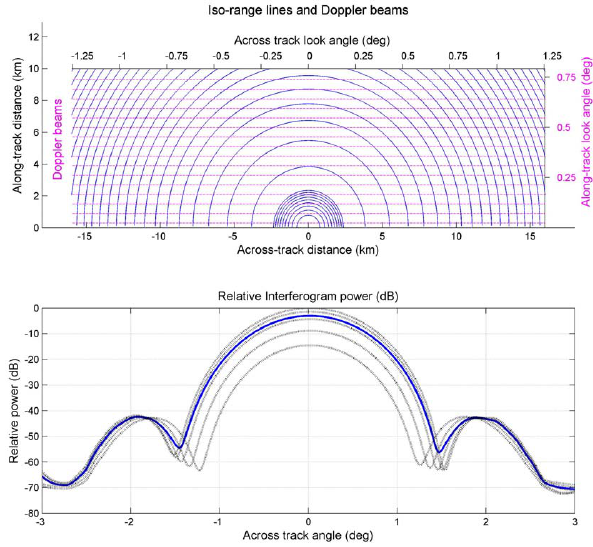
Fig. 2. (Top): the surface area illuminated by a burst of 64 pulses extends fore–aft and side-to-side of the sub-satellite point. A lo- cally circular Earth model has been used to illustrate the relative Figure 2 (top): The surface area illuminated by a burst of 64 pulses extends fore-aft and side- positions of some of the circular iso-range contours and half of to-side of the sub-satellite point. A locally circular Earth model has been used to illustrate the the 32 fore Doppler beam positions. The central (dark blue) semi- relative positions of some of the circular iso-range contours and half of the 32 fore Doppler circular contours illustrate the first nine iso-range contours after the beam positions. The central (dark blue) semi-circular contours illustrate the first 9 iso-range POCA. Subsequently, the blue semi-circles indicate the positions contours after the POCA. Subsequently, the blue semi-circles indicate the positions of every of every 25th iso-range contour. The 512 samples in each wave- form or scan line are separated in the L1b files used in this work by 25 th iso-range contour. The 512 samples in each waveform or scan line are separated in the 0.47m in slant range. The cross-track footprint dimension change L1b files used in this work by 0.47 m in slant range. The cross-track footprint dimension rapidly from the large size at POCA ( ∼ 1.5km) to ∼ 20m for the change rapidly from the large size at POCA (~1.5 km) to ~20 m for the 400 th footprint beyond 400th footprint beyond the POCA. The positions of the Doppler the POCA. The positions of the Doppler beams extending across-track are shown by dotted beams extending across-track are shown by dotted magenta lines, magenta lines, for clarity every second beam is shown. Both distance and angular coordinates for clarity every second beam is shown. Both distance and angular in degrees are given for the across- and along-track dimensions with respect to the POCA. coordinates in degrees are given for the across- and along-track di- mensions with respect to the POCA. (Bottom): the relative two-way antenna gain is shown for cross-track cuts at five different fore an- gles corresponding to the central and the 8th, 16th, 24th and 32nd beams. These are the dashed lines while the solid blue line corre- sponds to the effective two-way pattern G 2-way (θ) given in Eq. (6). Note that the cross-track angle extent in Fig. 2 (bottom) is much wider than that in Fig. 2